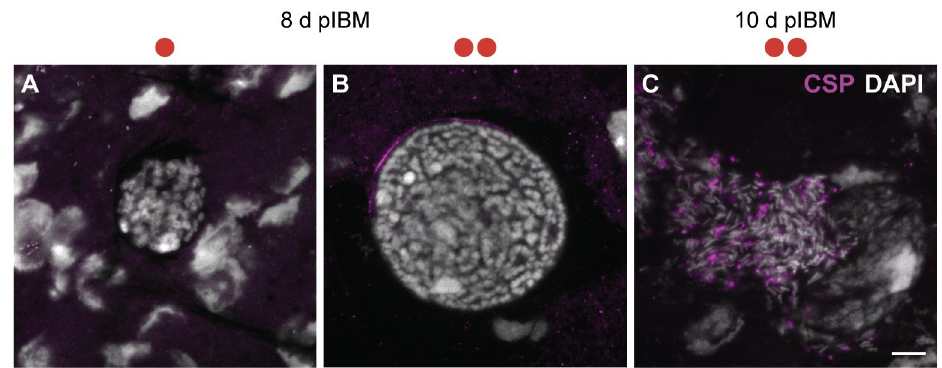
Fig 2. A second blood meal accelerates oocyst development. (A–B) Immunofluorescence assay of oocysts from control females (A) fed once (one red circle) or (B) fed twice (two red circles) at 8 d pIBM. (C) Oocyst from a female fed twice showing the release of mature sporozoites at 10 d pIBM. Sporozoites are labelled with circumsporozoite protein CSP (magenta) and DNA is stained with DAPI (gray). In all panels, scale bar = 10 μ m.